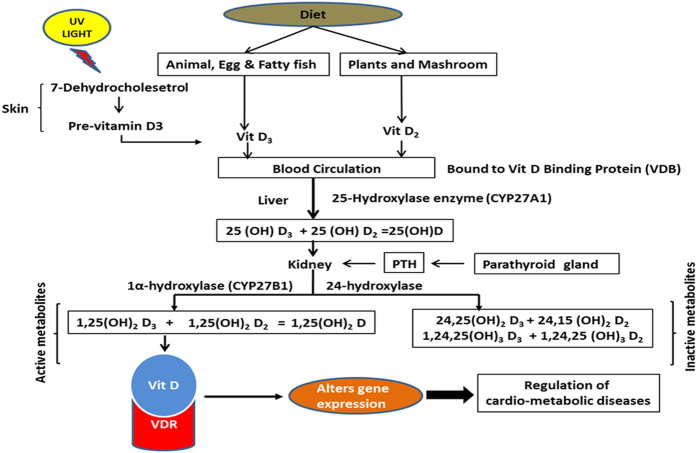
Vitamin D synthesis and metabolism:Vitamin D2 is synthesized from food whereas D3 is synthesized from 7-dehydrocholesterol by sun light. Vitamin D2 and D3 hydroxylate at 25 position in the liver to form 25(OH)D2 and 25(OH)D3, then hydroxylate again at position 1α to form active metabolites 1,25(OH)2D2 and 1,25(OH)2D3. These active metabolites participate in the biological activity.